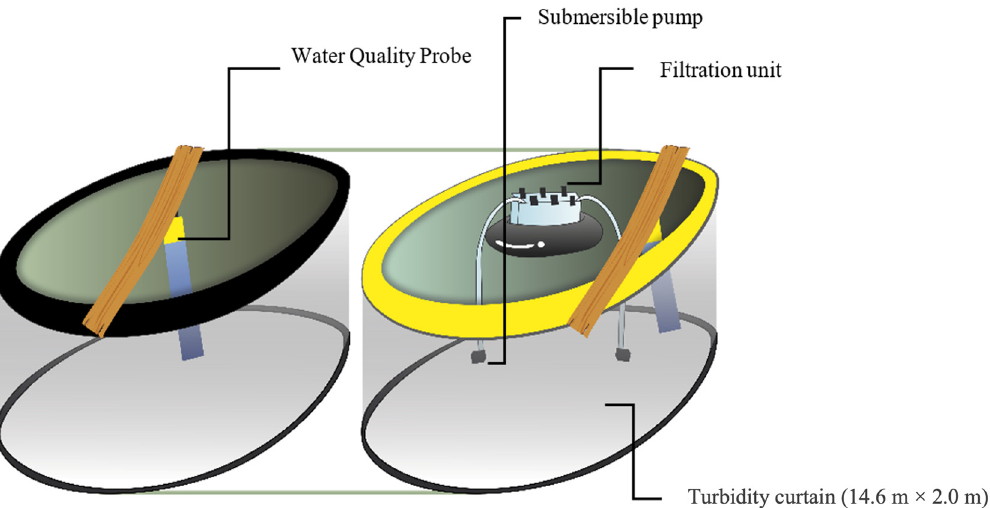
Figure 3. Schematic 3D view of the experiment enclosed areas. The control area is on the left and the filter is on the right.